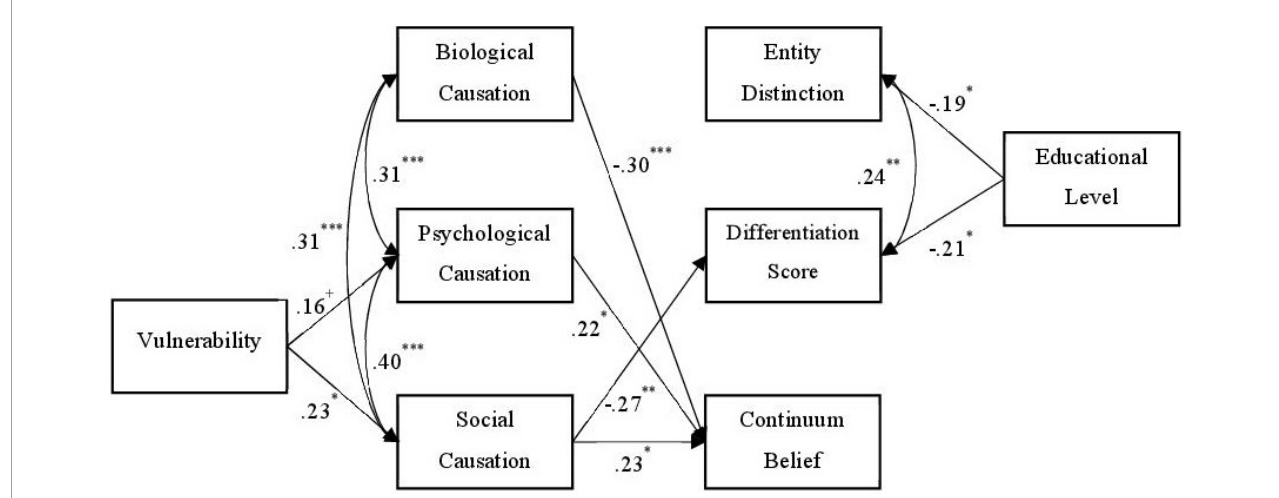
FIGURE3 Path model (depression group). N = 126. Standardized path coefficients. Nonsignificant paths are not displayed. Coefficients with p < 0.10 were included due to the small study sample. + p < 0.10, ∗ p < 0.05, ∗∗ p < 0.01, ∗∗∗ p < 0.001.